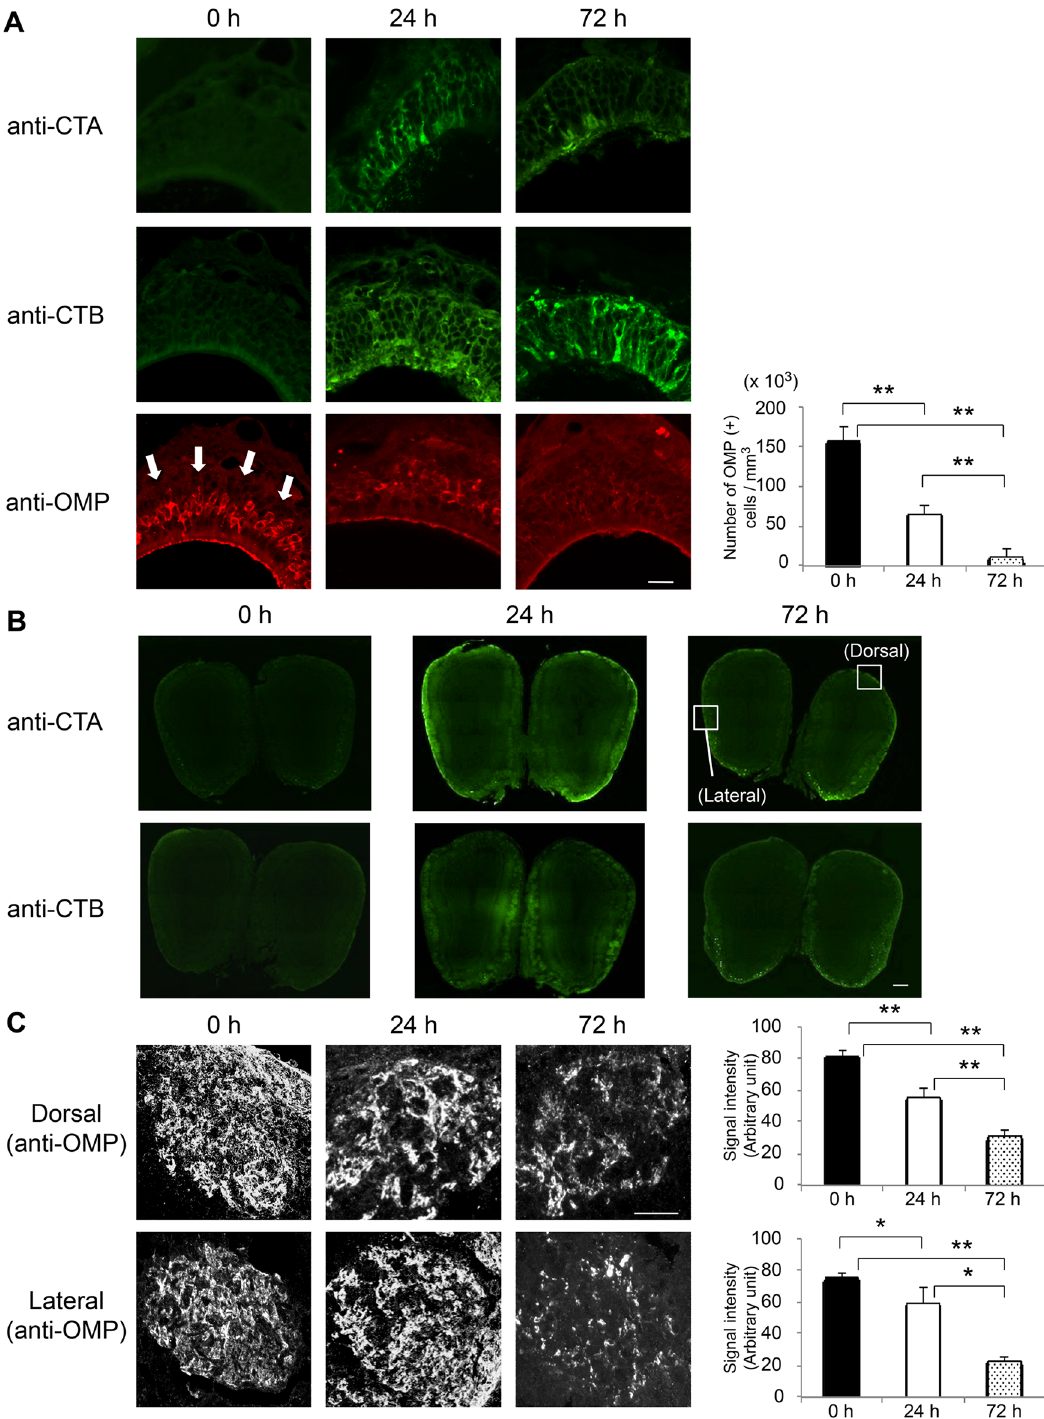
Fig 2. Immunohistochemical staining of the OE and OBs after nasal administration of 30 μ g CT. OE and OBs were obtained at 0 (untreated), 24, or 72 h after nasal administration of 30 μ g CT. ( A ) Frozen sections of OE were stained with an anti-CTA Ab or anti-CTB Ab (green) or an anti-OMP Ab (red). White arrows indicate the olfactory nerve layer. The number of OMP-positive cells (mean ± 1 SD; n = 3 mice) in each experimental group is shown at the right. ( B ) Frozen sections of OBs were stained with an anti-CTA Ab or anti-CTB Ab. ( C ) Frozen sections of OBs were stained with an anti-OMP Ab (converted to black and white images). Glomeruli at the dorsal and lateral surfaces of OBs (indicated by the boxes in panel B) are shown. The signal intensity (mean ± 1 SD; n = 3 mice) in each experimental group is shown at the right. Data are representative of three independent experiments. * P < 0.05, ** P < 0.01 (Student ’ s t -test). Scale bars: (A, C) 20 μ m, (B) 200 μ m. doi:10.1371/journal.pone.0139368.g002 PLOS ONE | DOI:10.1371/journal.pone.0139368 September 30,